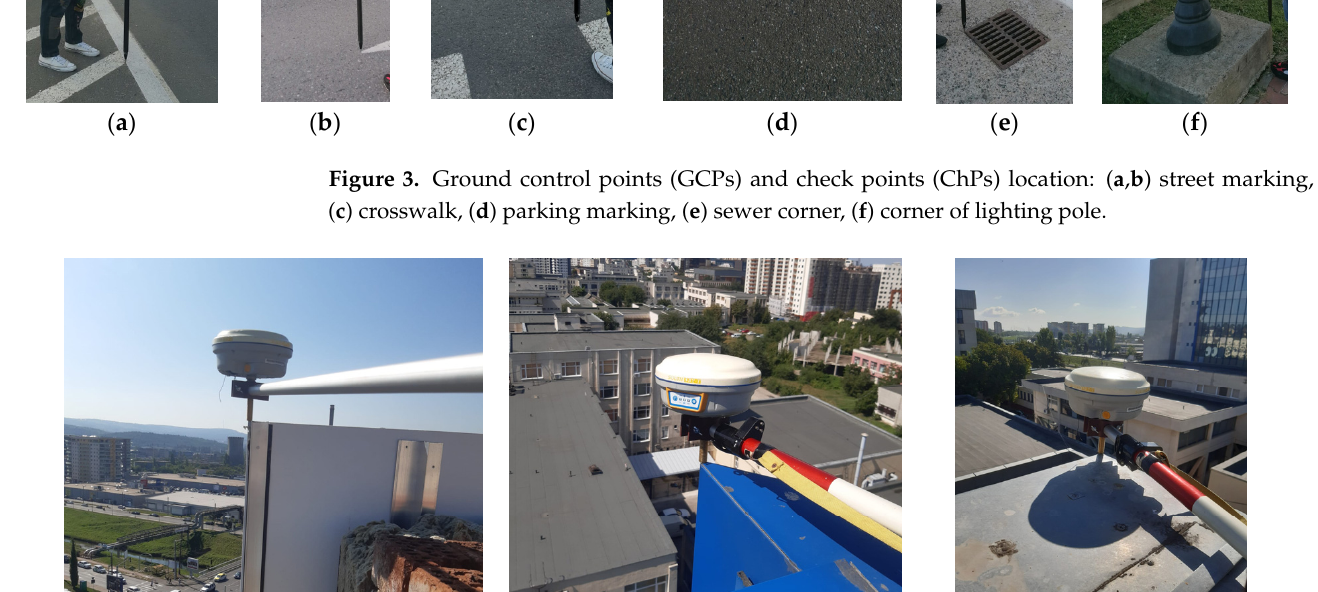
Figure 3 . Ground control points (GCPs) and check points (ChPs) location: ( a ), ( b ) street marking, ( c ) crosswalk, ( d ) parking marking, ( e ) sewer corner, ( f ) corner of lighting pole.